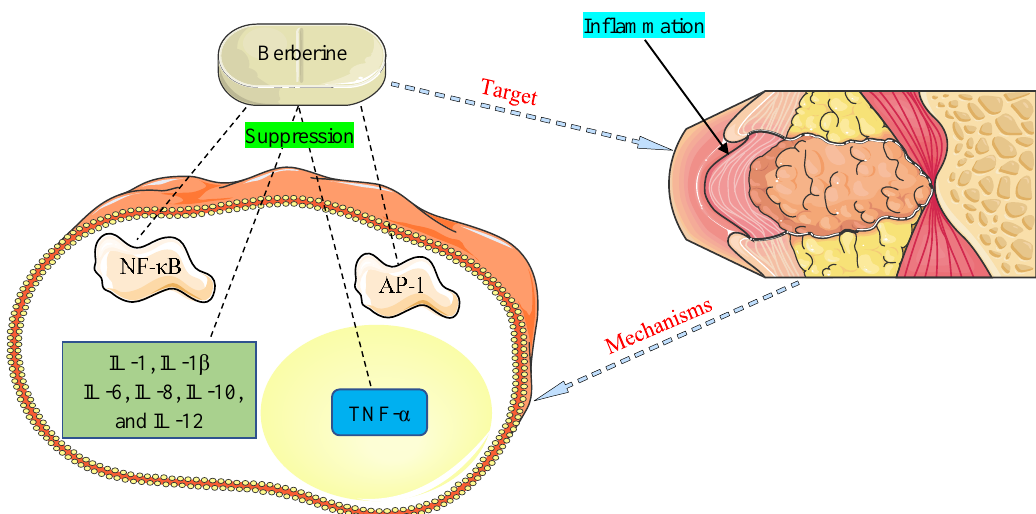
Figure 3. Mechanisms by which berberine demonstrates anti-inflammatory properties against inflammation associated with human oncogenic herpesviruses. AP-1, activator protein-1; IL-1, interleukin-1; IL-1 β , interleukin-1 β ; IL-6, interleukin-6; IL-8, interleukin-8; IL-10, interleukin-10; IL-12, interleukin-12; NF- κ B, nuclear factor-kappa B; TNF- α , tumor necrosis factor- α.